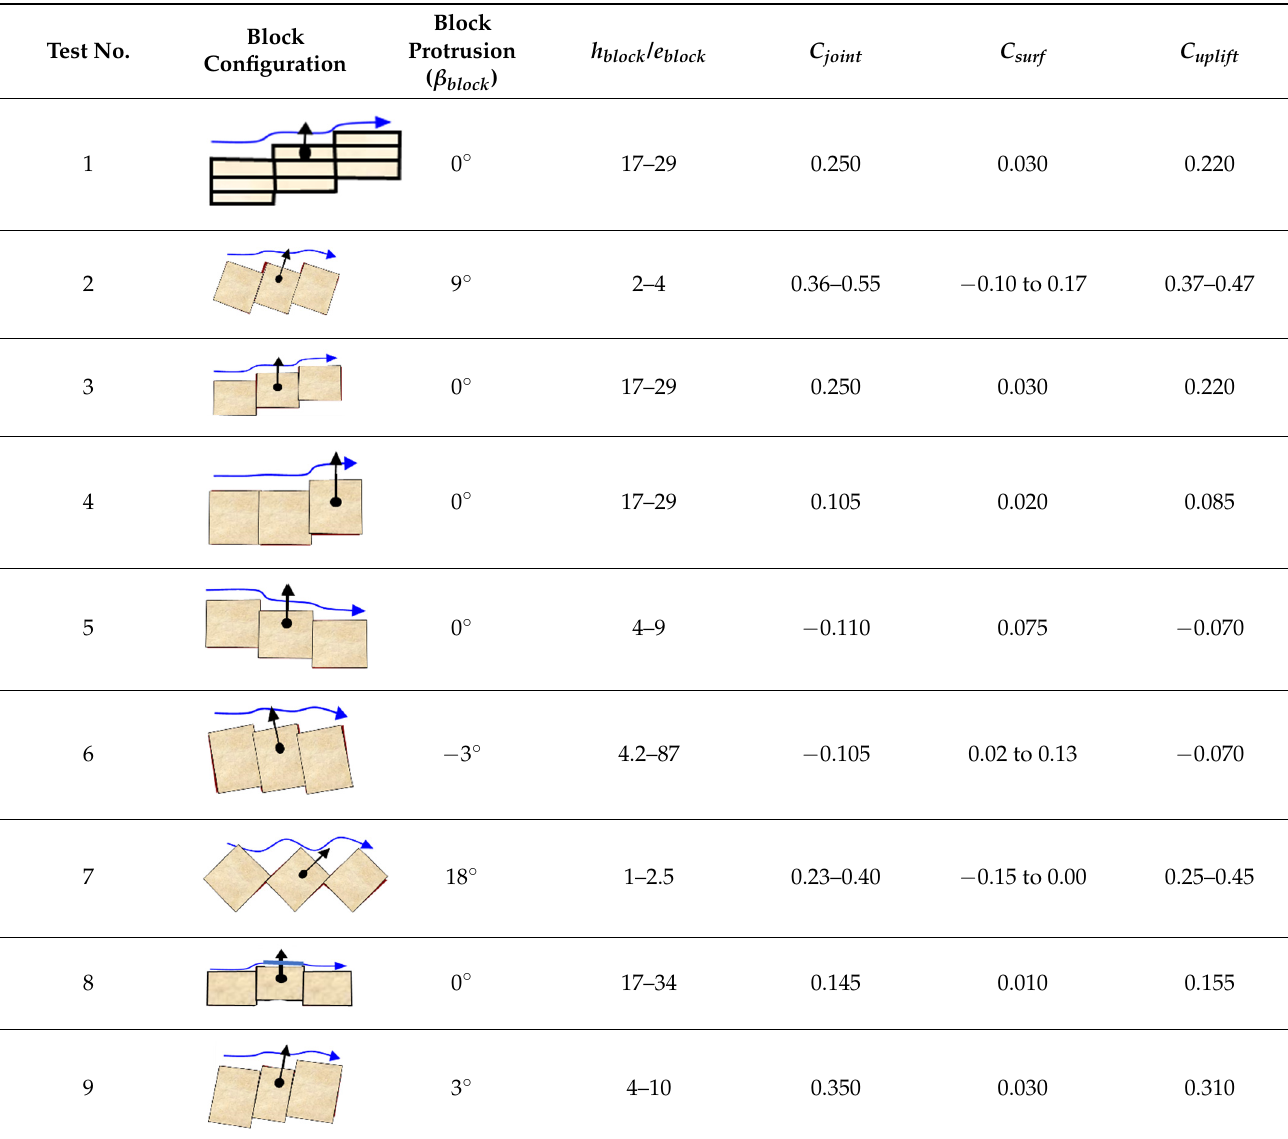
Table 11. Net uplift stagnation pressures for the various setups of block projection and joint points [82]. Test No. plunging jet velocity with a dimension of m/s, and Z is the water depth.